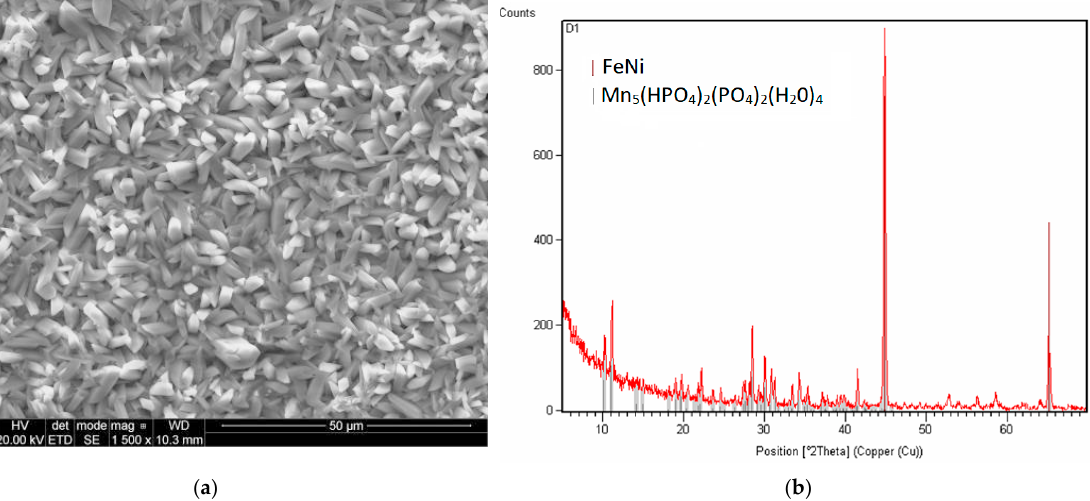
Figure 16. Microphotographs of the sample of a coating modified with barium nitrate ( a ) and XRD spectrum ( b ).